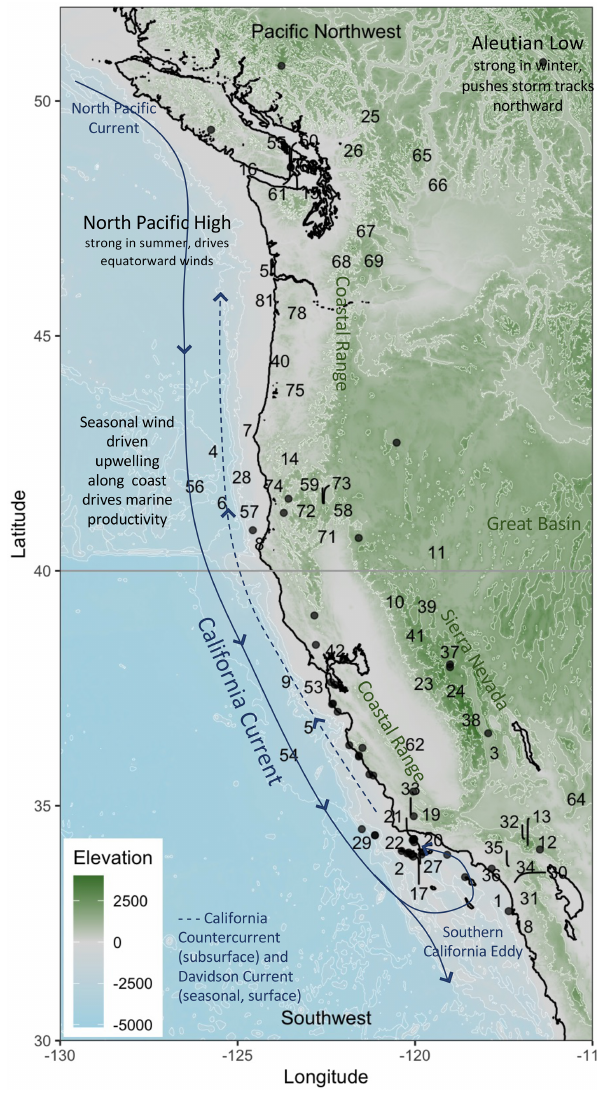
Figure 1. Map of locations of all studies reviewed in the paper with simplified schematic of modern oceanographic and hydrographic conditions. Sites used in spatiotemporal analysis are numbered; numbers correspond to papers listed in Appendix A. Sites used in literature review are included as black dots. Gray horizontal line shows delineation between Pacific Northwest and Southwest for the purposes of this